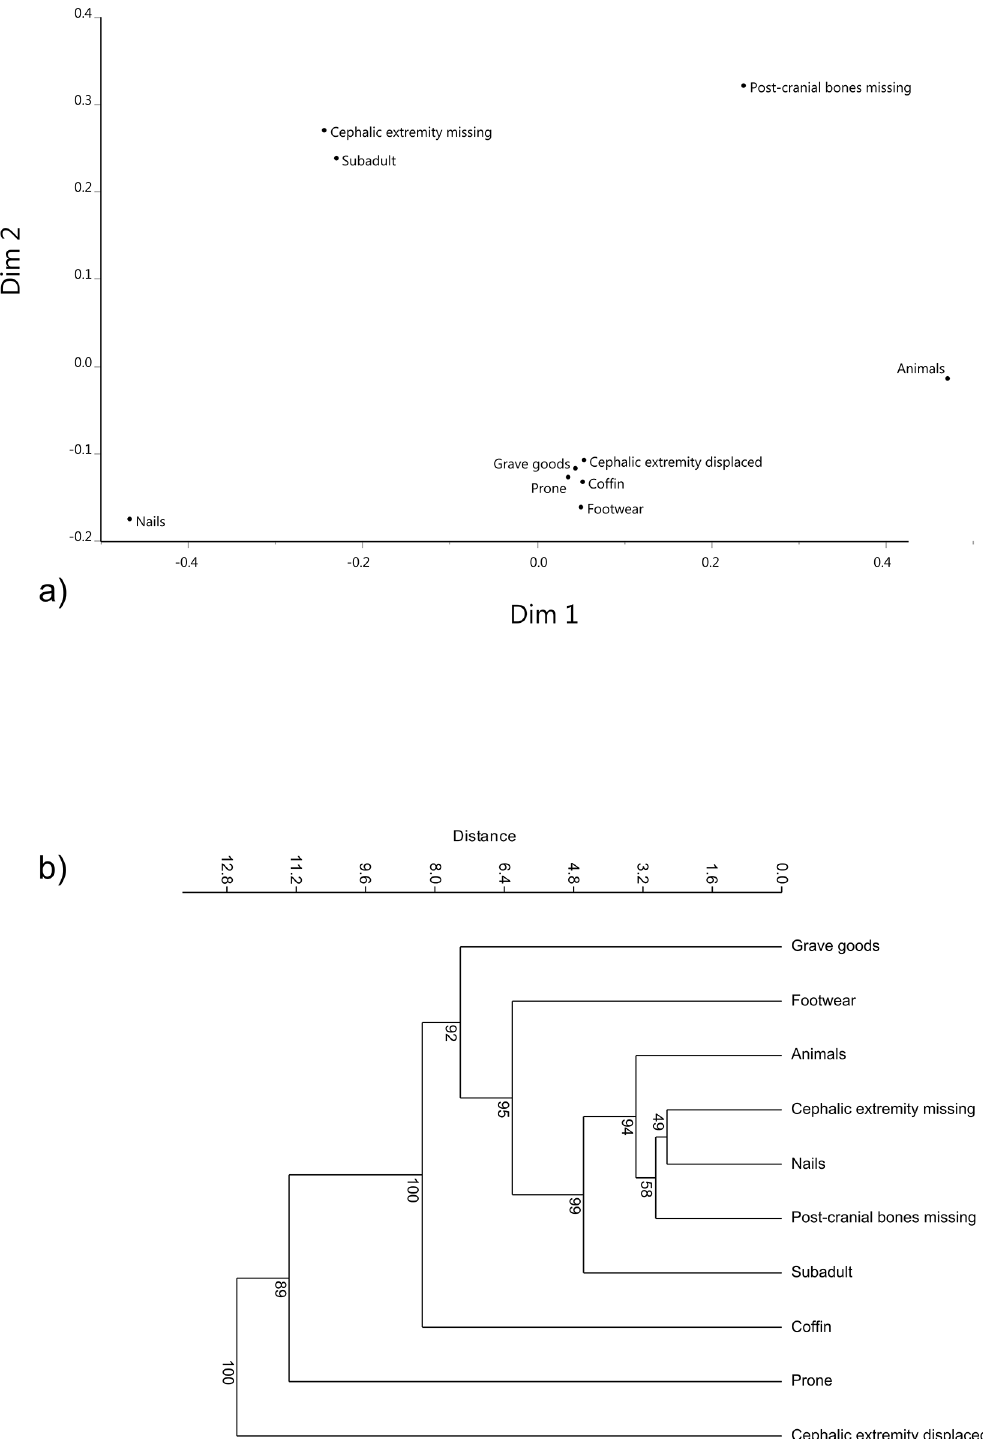
Fig 2. Britain. a) Non-metric multi-dimensional scaling of burial similarities. Note the association of grave furnishing (grave goods and coffins) with prone burials and burials with the cephalic extremity displaced. b) Cluster analysis of burial features.